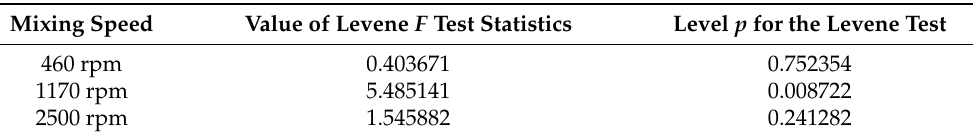
Table 6. Results of the Levene tensile strength test of adhesive compositions as a function of mixing